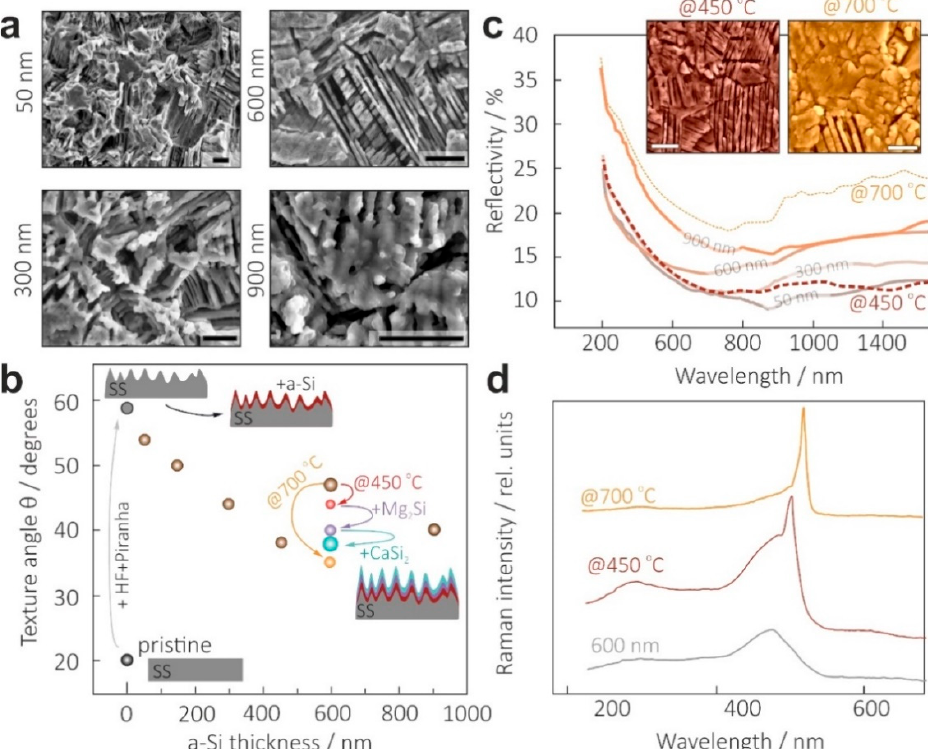
Figure 3. Optimization of the growth temperature and thickness of the Si layer capping b-SS. ( a ) Top-view SEM images showing morphology variation and surface flattening of the b-SS samples with an increase in Si layer thickness from 50 to 900 nm. Scale bar indicates 10 µm. ( b ) Texture angle evolving upon increase in Si thickness (brown markers) as well as after each fabrication step of the prototype SC device (colored markers). ( c ) Influence of Si layer thickness and growth temperature on the optical properties of the b-SS/Si template structure. The insets show surface morphology of the b-SS/Si sample heated at 450 and 700 °C. Scale bar indicates 2 µm. ( d ) Crystallinity of Si layers deposited under different growth conditions accessed by Raman